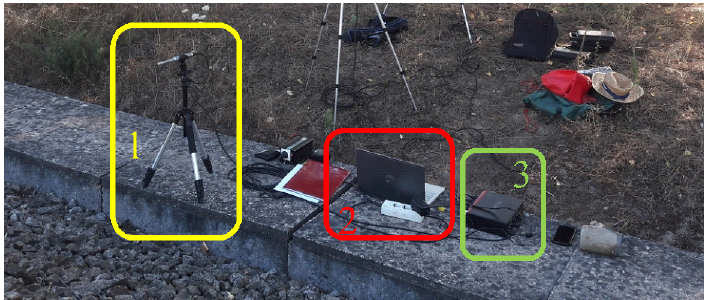
Figure 2. Experimental setup for the acoustic signal acquisition; ( 1 ) Behringer ECM 8000 microphone, ( 2 ) computer, ( 3 ) Focusrite Sclarett 4Pre USB acquisition unit.